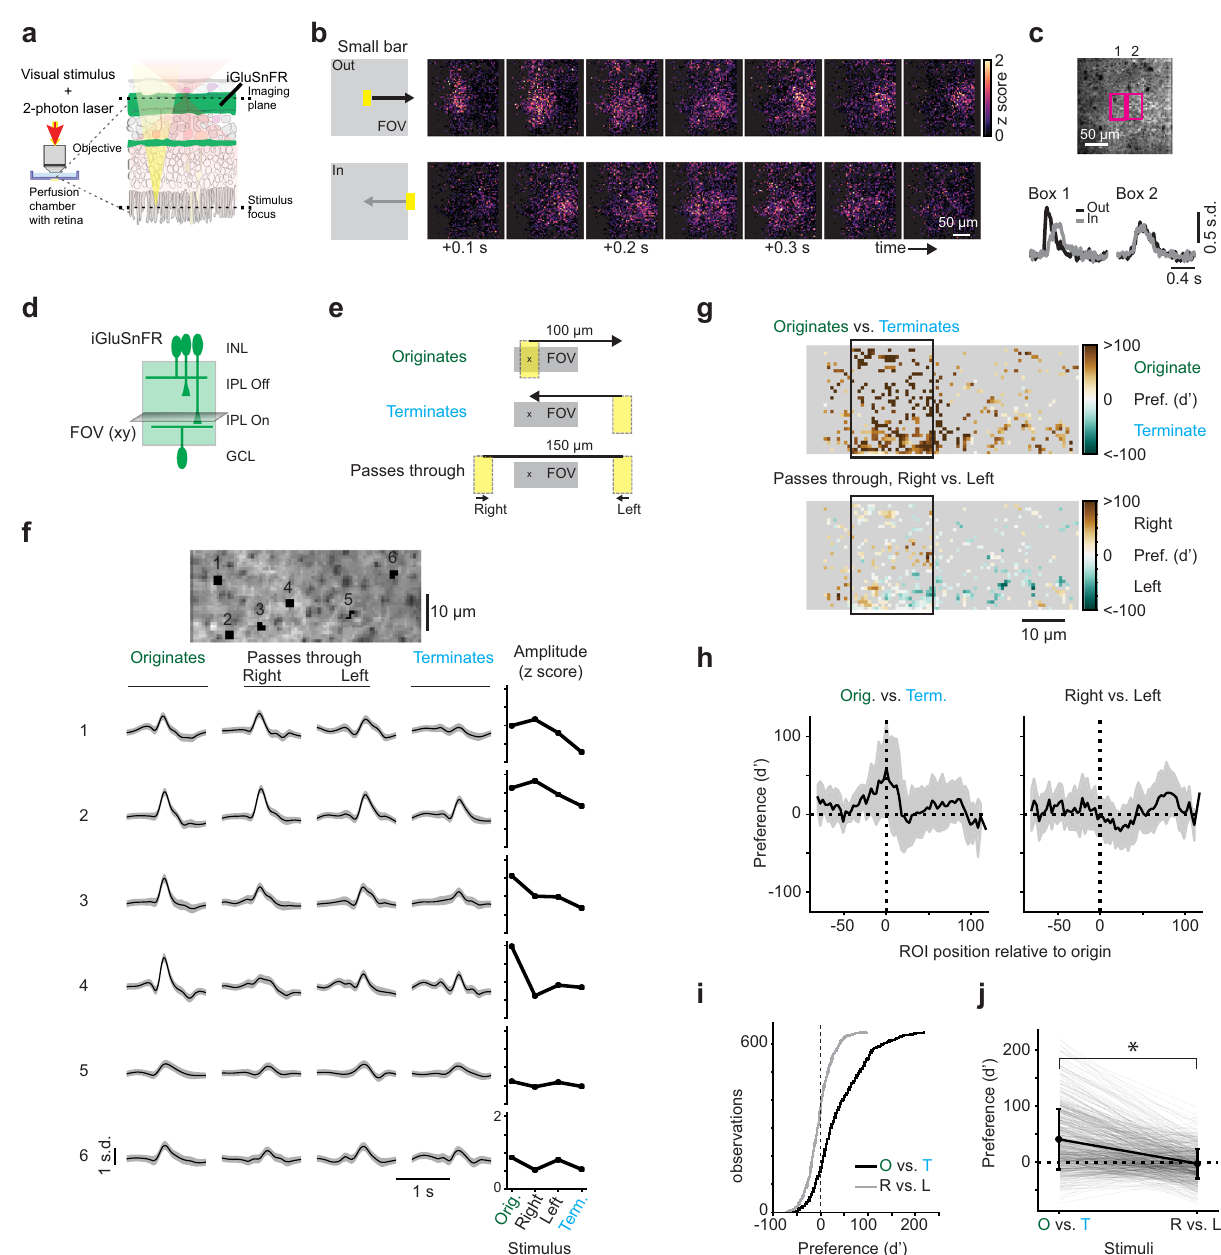
Fig. 1 | Bipolar cell glutamate release is radially direction selective. a Experimental setup showing objective, retina, visual stimulus (yellow), and 2-photon laser (red). Adapted from ref.61. b Left: stimulus (20×40 μ m light rec- tangleondarkbackground)movingat500 μ m/sover100 μ m,startingeitherinthe fi eld of view (FOV) center or just outside the FOV. Right: montage of the average z-scored fl uorescence of glutamate sensor iGluSnFR during stimulation. Repre- sentative example, experiment repeated in 3 retinas/2 animals. c Top: average iGluSnFR fl uorescence showing two regions of interest (ROIs). Bottom, mean bin- ned fl uorescenceforthepixelsineachROI. d iGluSnFRisubiquitouslyexpressedin retinal neurons, including in the cells of the inner plexiform layer (IPL, green region). INL, inner nuclear layer; GCL, ganglion cell layer. e Moving bars (20×40 μ m) presentedto the retina originating in the FOV (green), terminating in the FOV (cyan), or passing through in two directions (black). All objects to scale. f ExampleROIs(blackregions,numbered)overlaidwiths.d.oftheimaged fi eldand